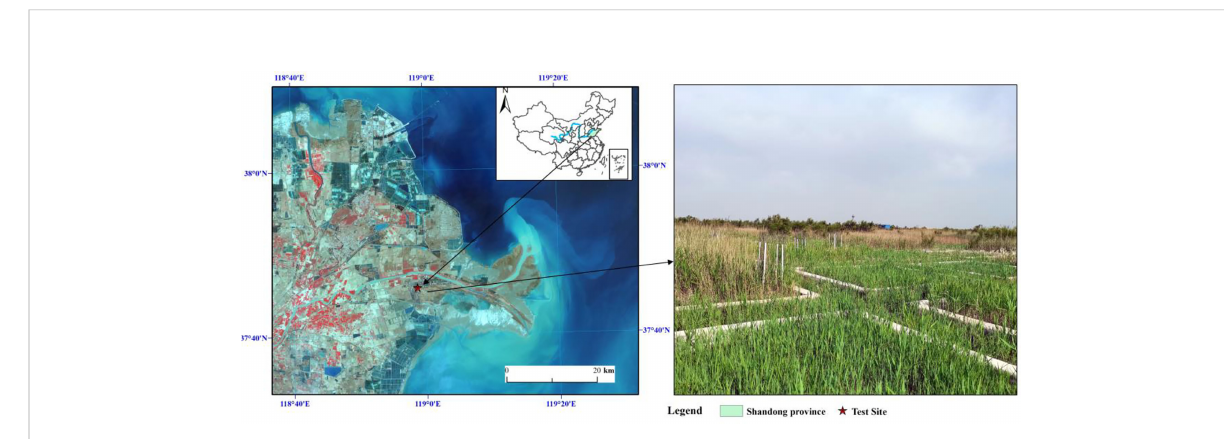
FIGURE 1 Location and layout of the experimental plots used to simulate mowing